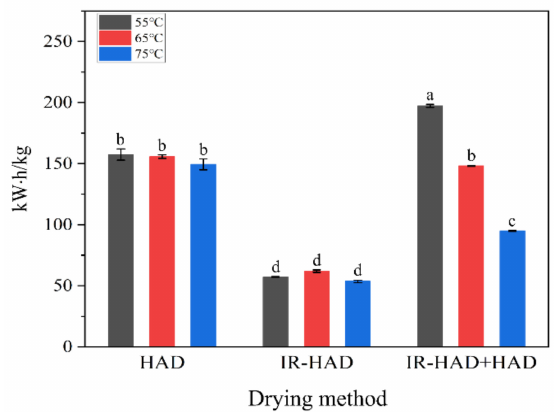
Figure 5. Specific energy consumption for dried chrysanthemum cakes from different drying strate- gies. Different lowercase letters on the bar graph represent significant differences ( p <